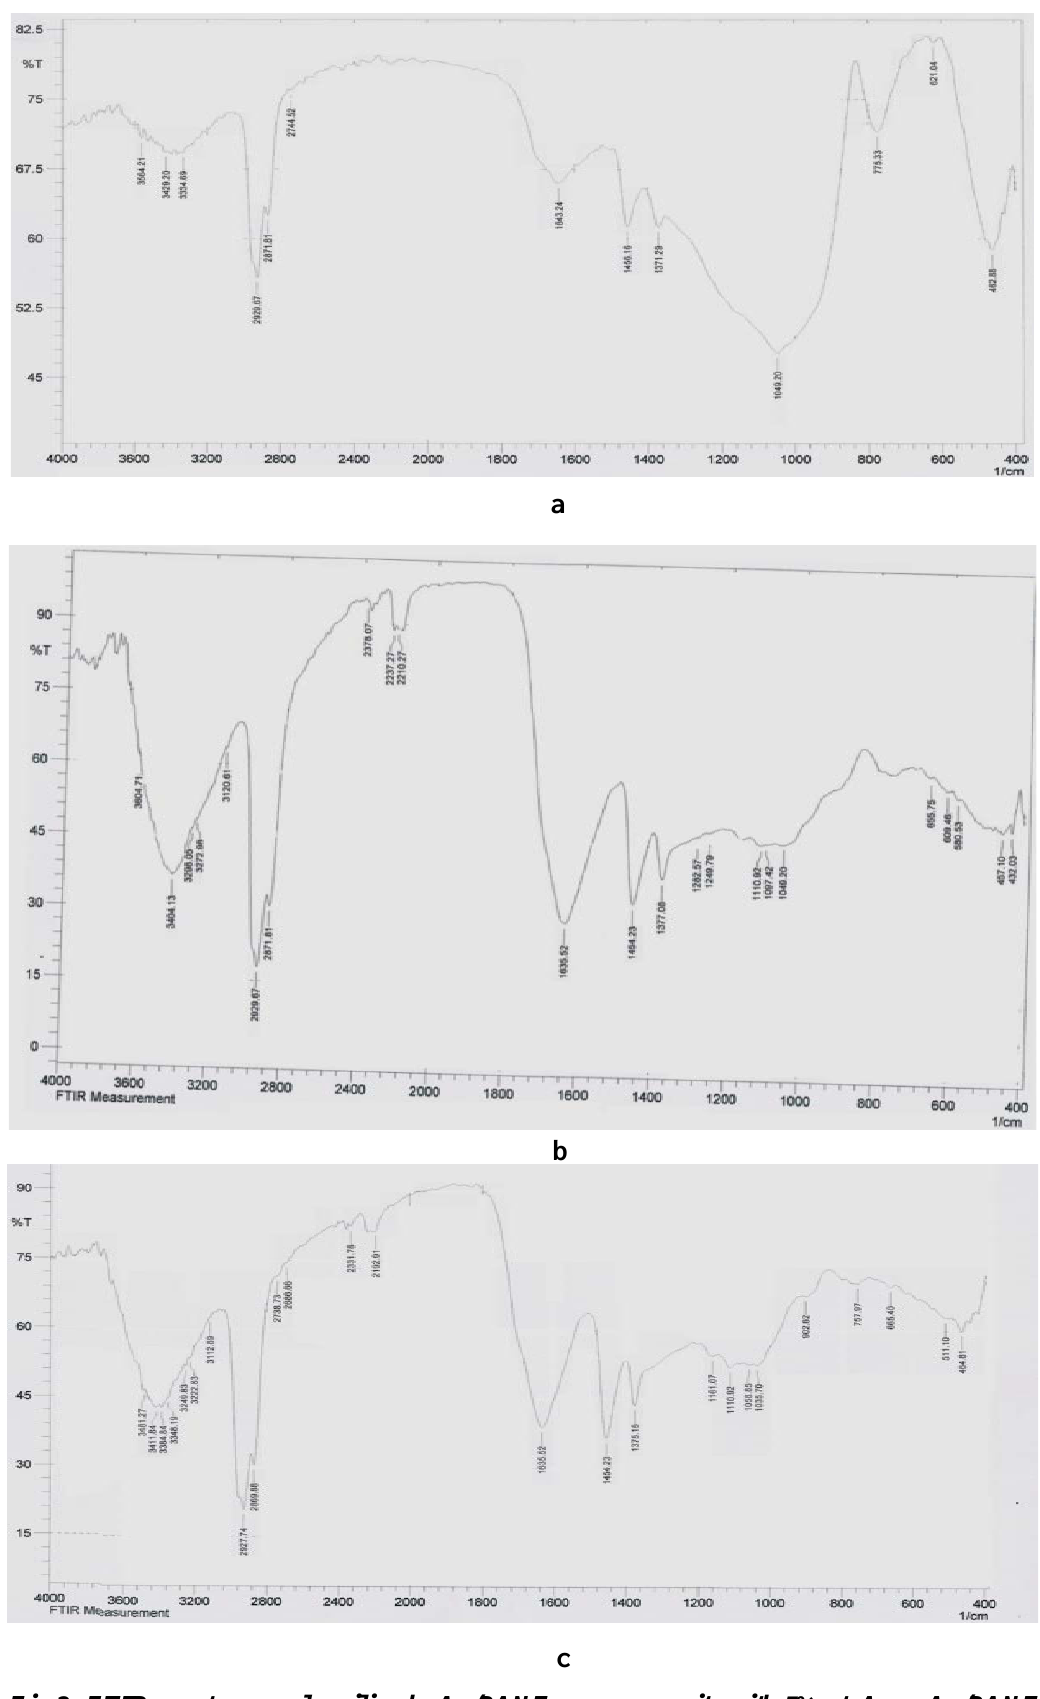
Fig.3 :FTIR spectra a- polyaniline b- Ag/PANI nanocomposite with 5%wt. Ag c- Ag/PANI nanocomposite with 11%wt.